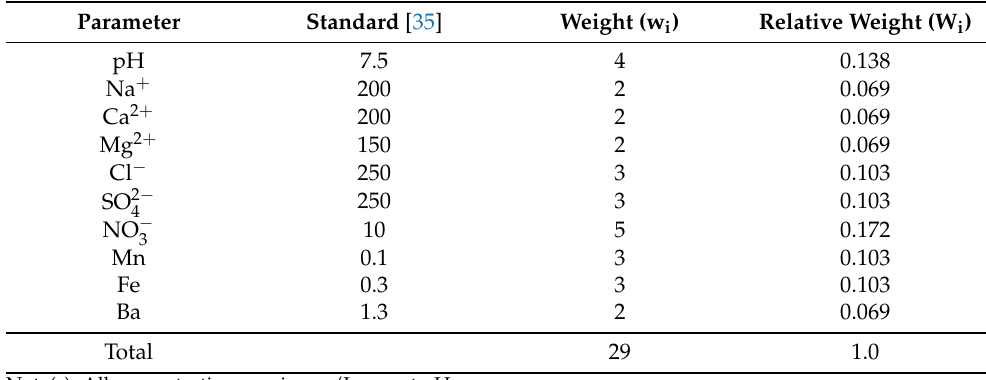
Table 1. List of parameters used to calculate the WQI, their standard drinking water reference values [35], for drinking water, assigned weights (w i ) and relative weights (W i